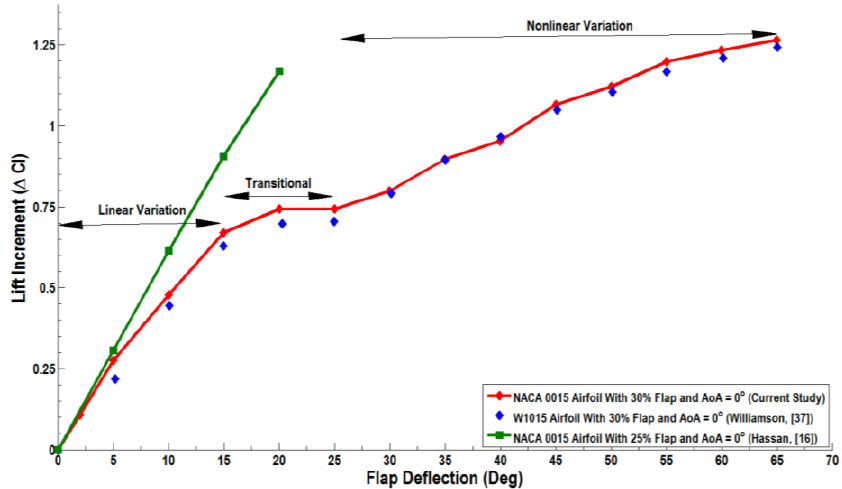
Figure 19. Variation of ∆ C l with flap deflection at zero AoA and comparison with the experimental data of Williamson [34] and simulations of Hassan [16].